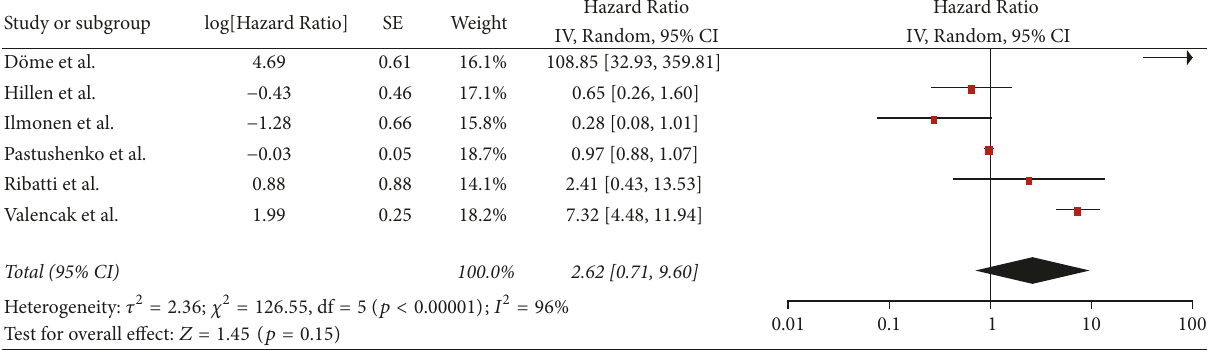
Figure 2: Hazard Ratio of overall